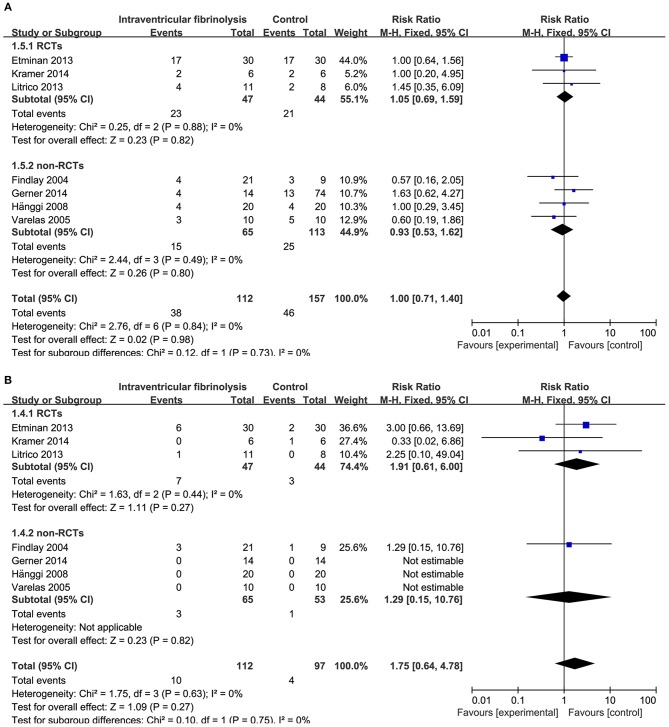
Meta-analysis of associations between intraventricular fibrinolysis and the risk of chronic hydrocephalus (A) or the risk of hemorrhagic complications (B) in patients with aSAH. aSAH, aneurysmal subarachnoid hemorrhage; CI, confidence interval; M–H, Mantel–Haenszel method; RCTs, randomized controlled trials.